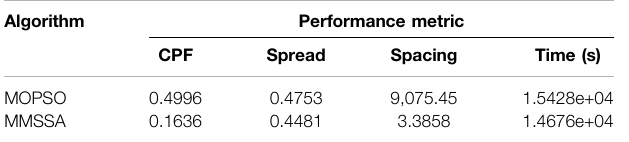
TABLE 2 | Comparison of performance metrics of two